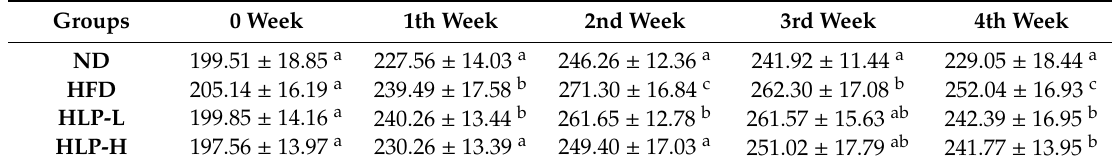
Table A2. The changes of